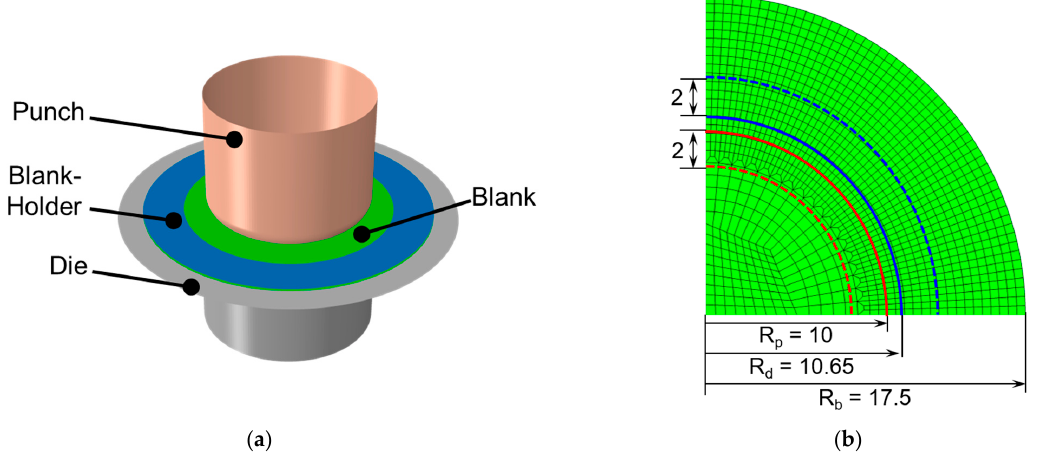
Figure 11. ( a ) Schematic of the FE model. ( b ) A quarter of the FE mesh of the blank, including dimensions of the punch and die projected on the